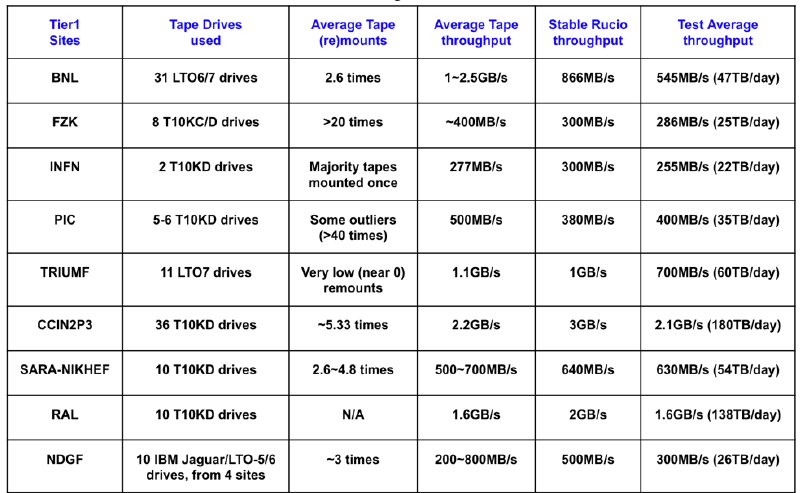
Table 1. Phase I tape test results